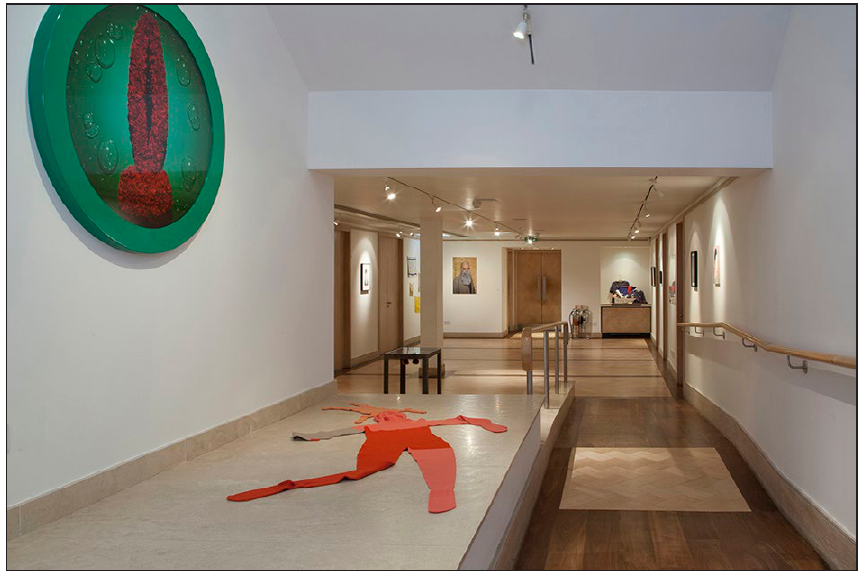
Figure 8: Installation shot of Mad Mother , (machine and hand knitted wool, 2300 × 1520 × 20 mm), in Liberties , Collyer Bristow Gallery, London, UK, 2015. Left hand wall – Helen Chadwick, Wreath to Pleasure No. 8 , 1992–1993. Photograph: Stephanie